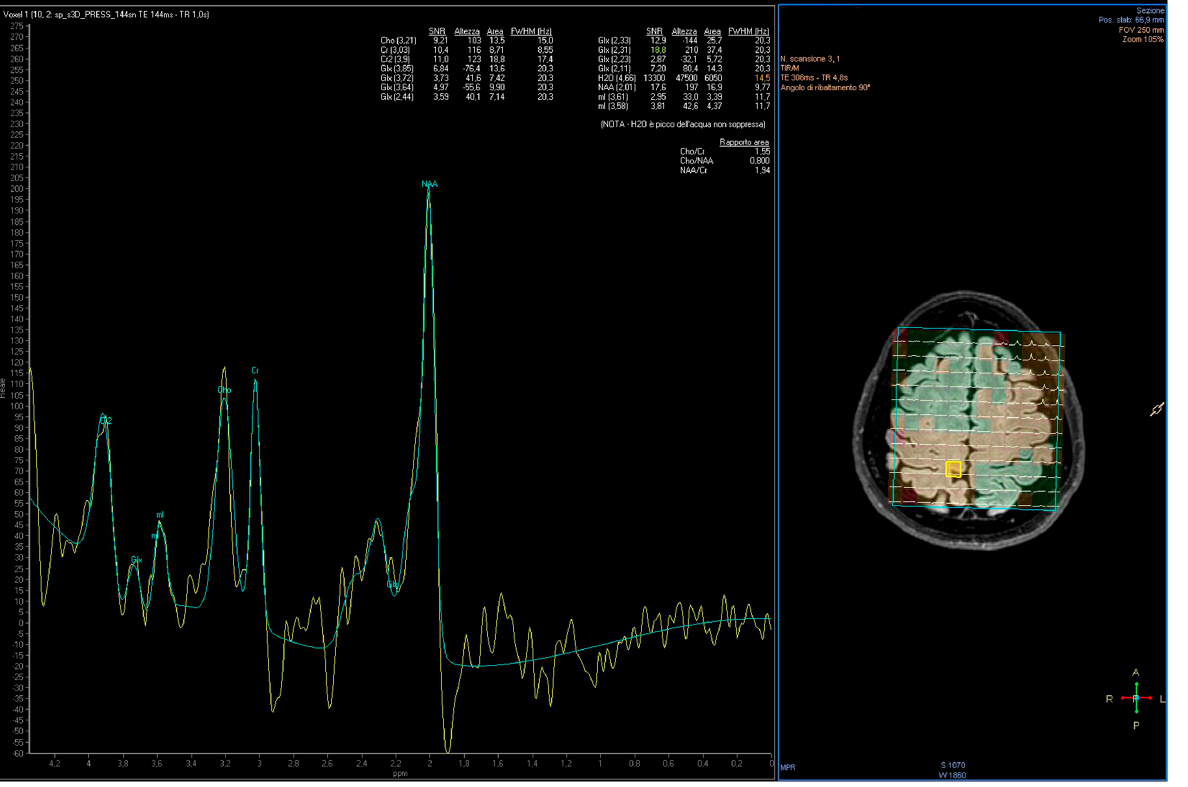
Figure 1. Voxel position from the motor cortex and representative spectra obtained from a PD patient. Lengend: Commas represents the decimal separator.